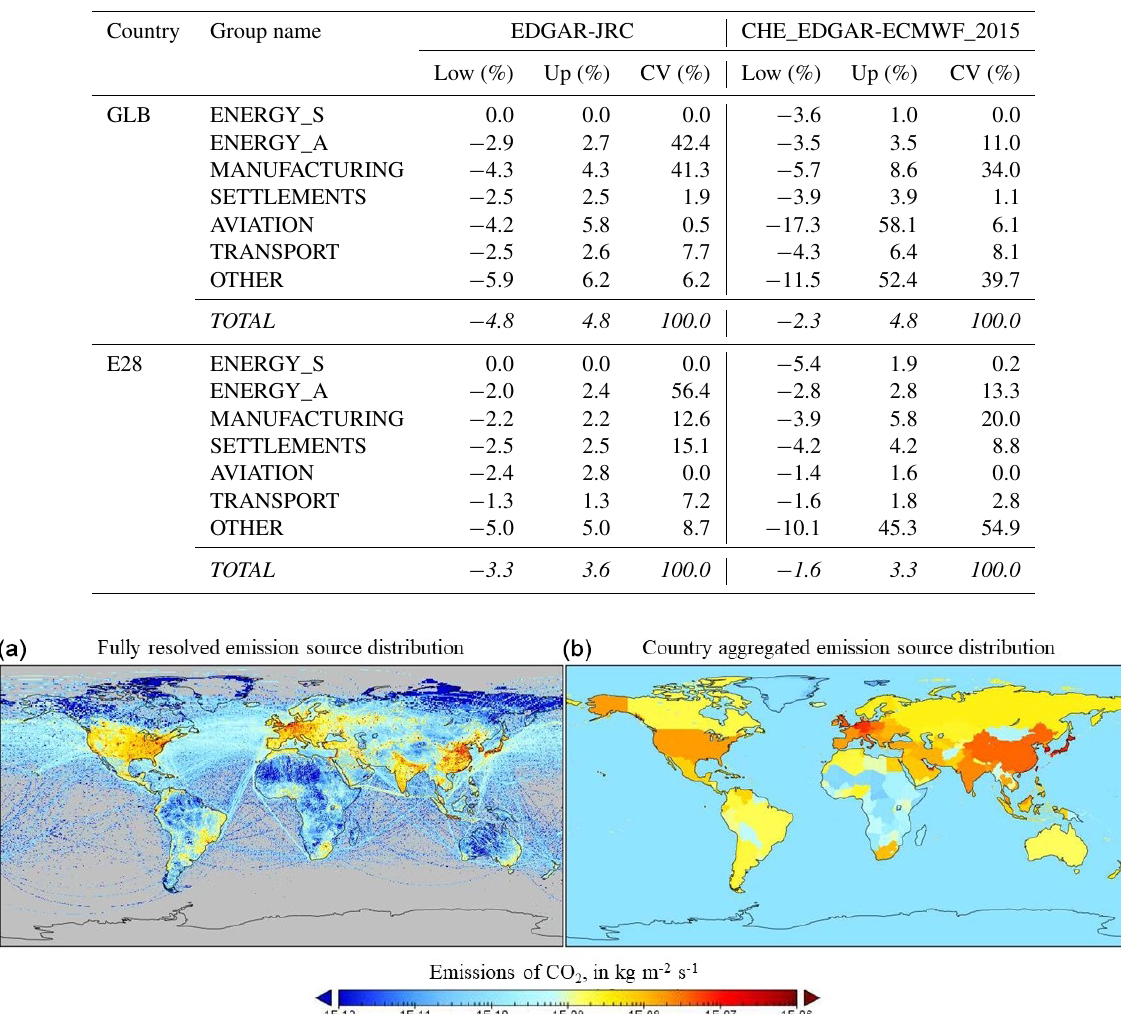
Table 9. Aggregated to the group level uncertainties (lower- and upper-half ranges of uncertainty) in percent and contributions in percent to the total uncertainty (CV) for Europe (E28) and the globe (GLB) from EDGAR-JRC (with extra fuel type knowledge) and CHE_EDGAR- ECMWF_2015 (with typical fuel only).